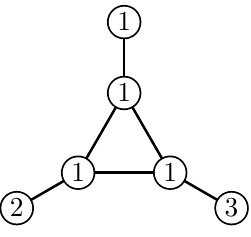
Figure 1. A local inclusive distance vertex irregular labeling of C 3 (cid:12) K 1